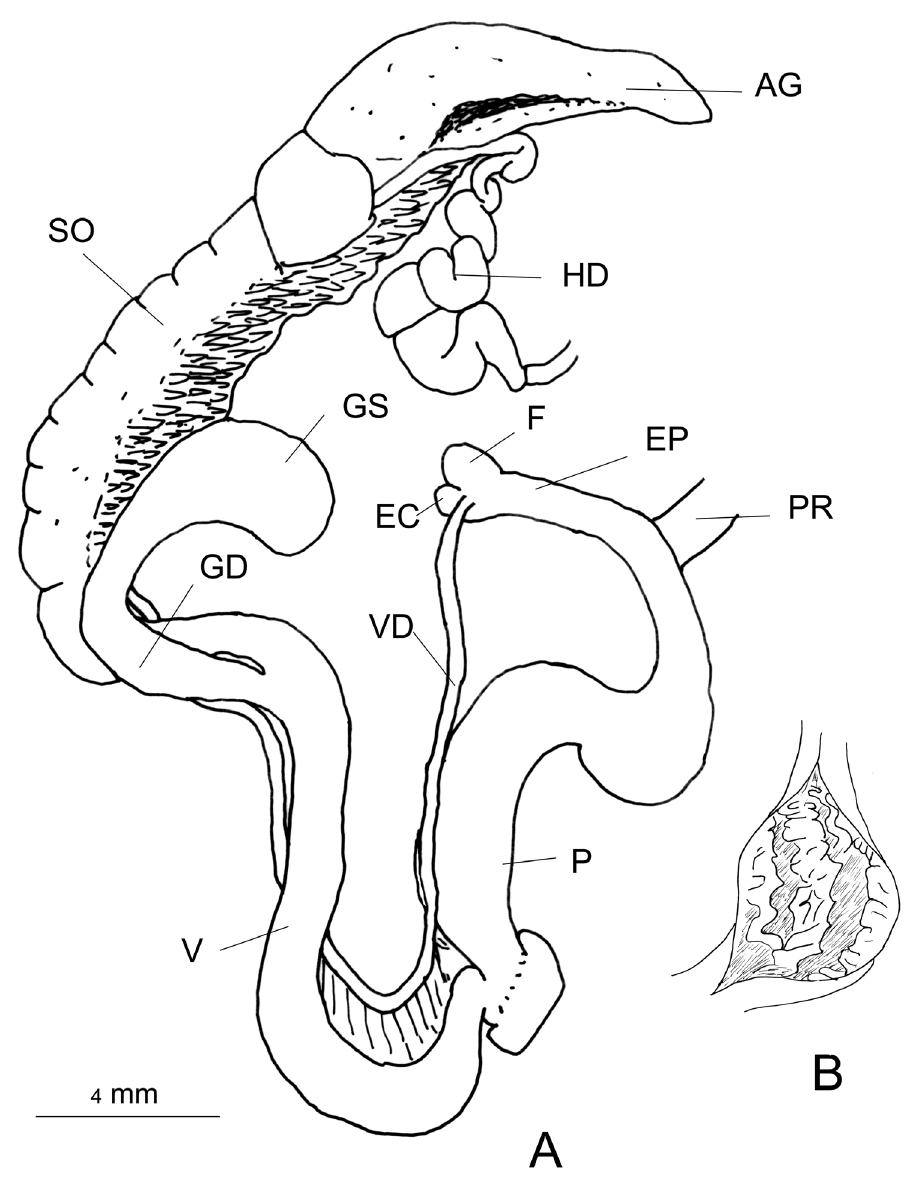
Figure 9. Genitalia of R. nagarjunensis sp. n., holotype: CDZMTU067P, A General view B Interior of penis of the same, Nagarjun forest, Balaju-Jamacho trail Nagarjun-Shivapuri National Park, Kathmandu,